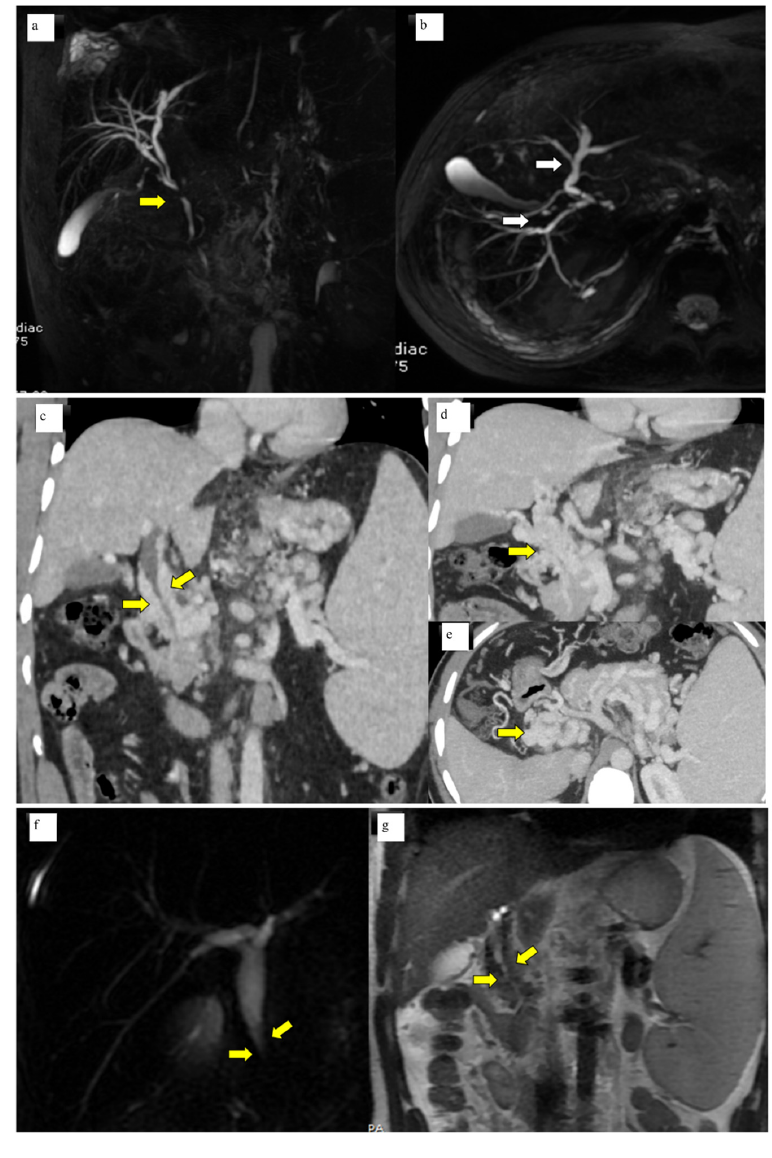
Figure 1. ( a ) MRCP Coronal & ( b ) 3D axial MRCP showing extrahepatic (Bold yellow arrow) and intrahepatic biliary dilatation (bold white arrows) with ductal wall irregularity in a case of well ‐ delineated portal biliopathy of a 16 ‐ year ‐ old young boy. ( c ) Coronal Contrast ‐ enhanced CT scan of the abdomen showing opacified paracholedochal collaterals (bold yellow arrows) along the length of the common bile duct causing extrinsic luminal compression. (d) Coronal Contrast ‐ enhanced CT Scan of the abdomen showing multiple opacified portal cavernoma collaterals along the entire length of the common duct (bold yellow arrow), extending up to suprapancreatic segment. ( e ) Axial contrast ‐ enhanced CT section of the upper abdomen shows portal cavernoma as a bunch of collat ‐ erals in the spleno ‐ portal confluence and the SMV which cannot be separately identified from the collaterals (yellow bold arrow). ( f ) Coronal 2D Magnetic resonance cholangiopancreatography (MRCP) image showing narrowing of the distal common duct segment (bold yellow arrows) due to extra luminal collaterals seen as T2 hypointense flow voids (bold yellow arrows). ( g ) Coronal T2 WI of the MRI of the upper abdomen.